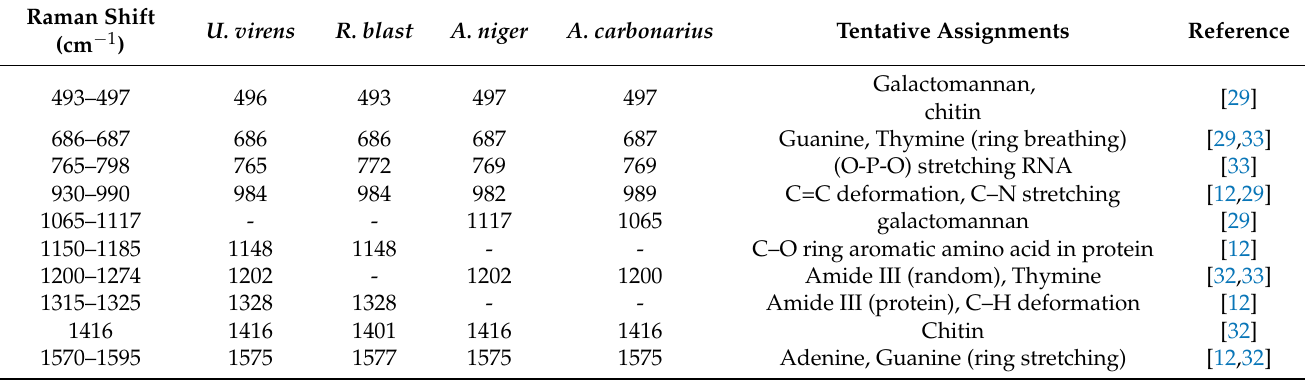
Table 1. Peak assignment of the average spectrogram of the four spores.